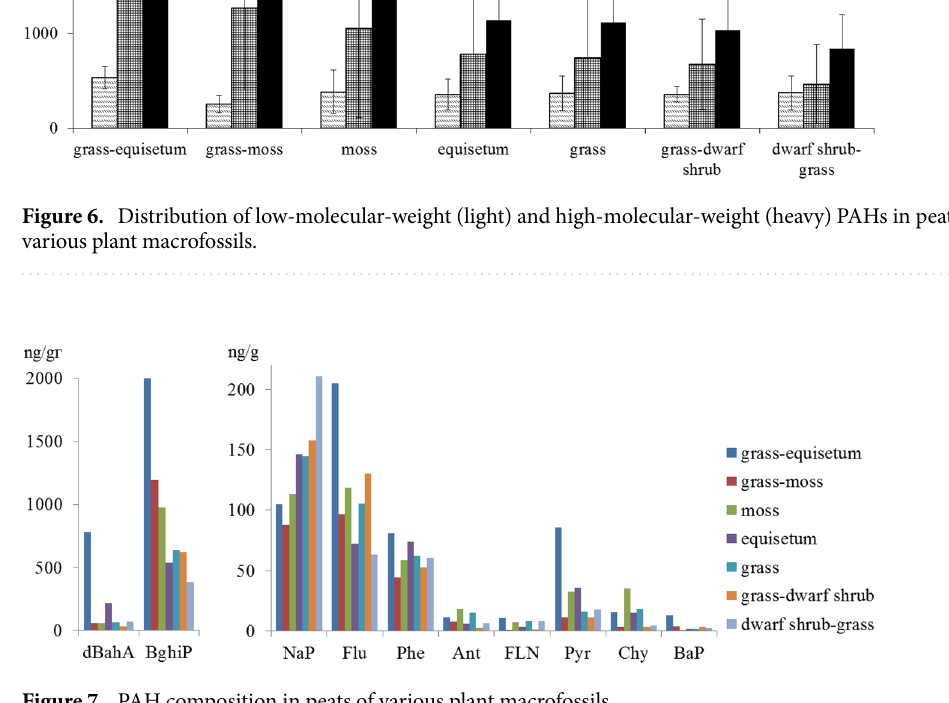
Figure 7. PAH composition in peats of various plant